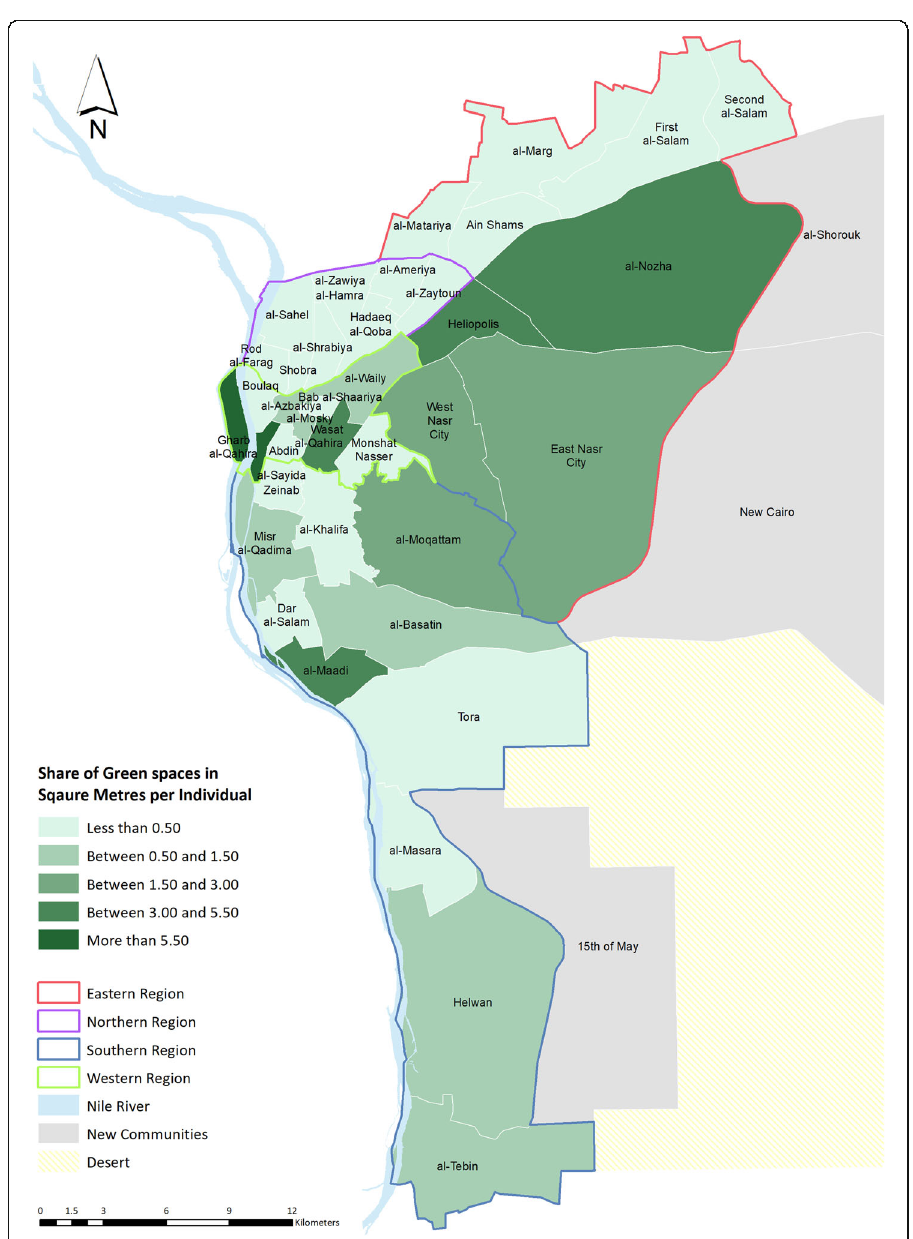
Fig. 4 Individual share of green spaces in Cairo based on 2020